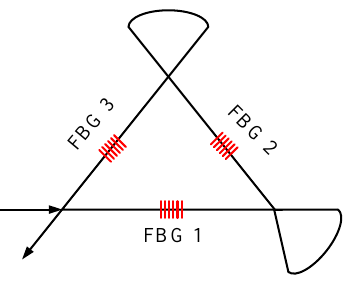
Figure 5. Rosette configuration of FBG